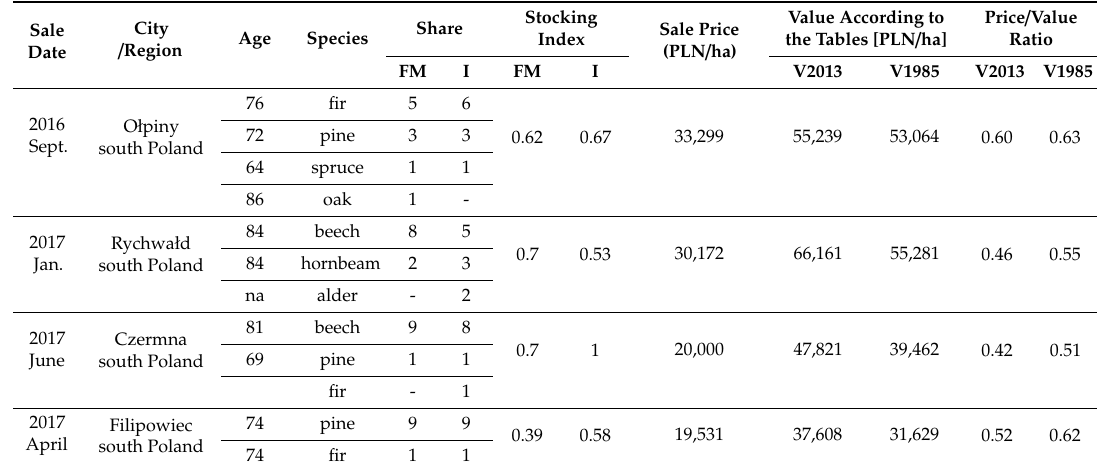
Table A1. Visual inspection results.